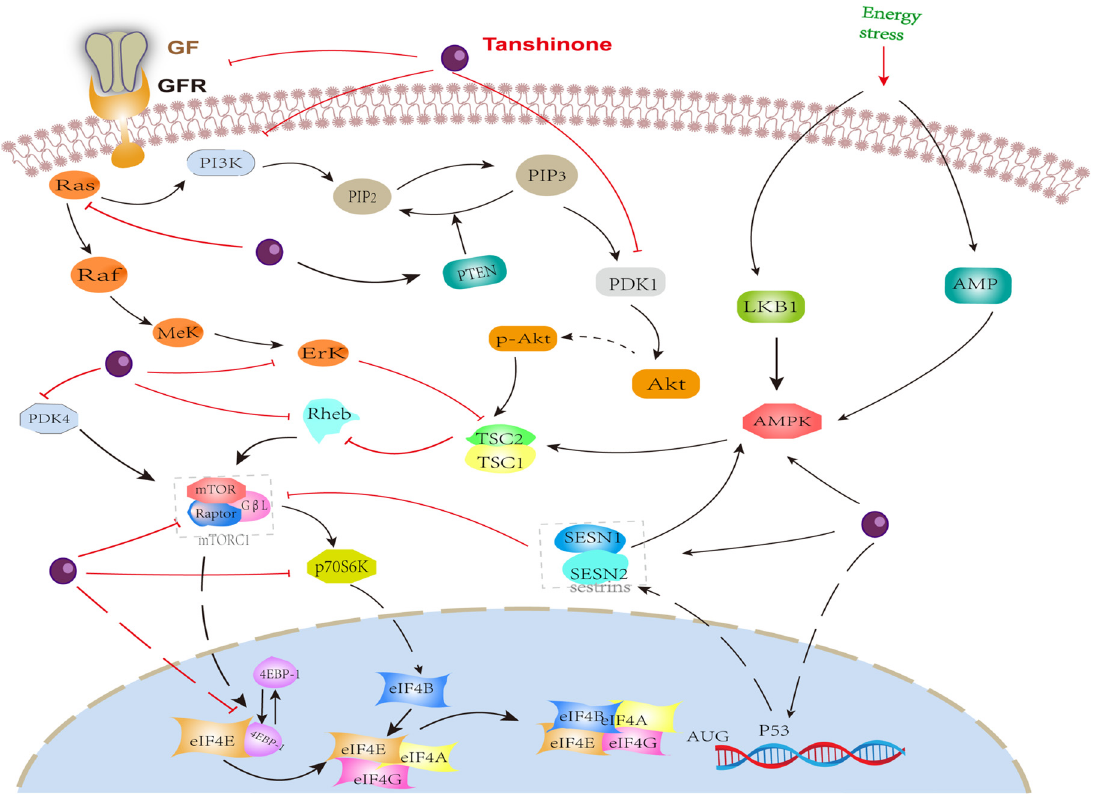
Figure 3. Effect of Tanshinone on mTOR. induced by Tanshinone are noted by using → , while the inhibition represented by (cid:97)